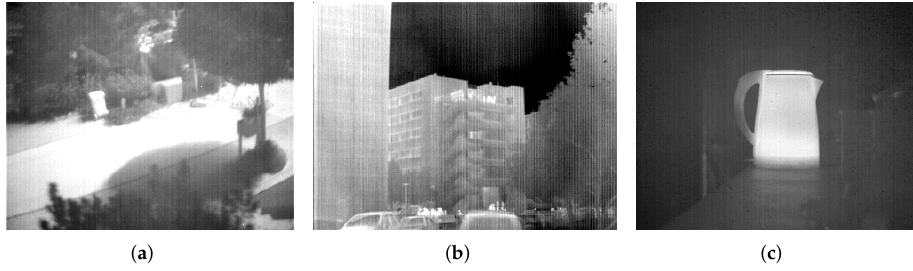
Figure 5. Three raw IR images for testing. ( a ) Street from ASL dataset [28]; ( b ) Building from Tendero’s dataset [13]; ( c ) Kettle from our